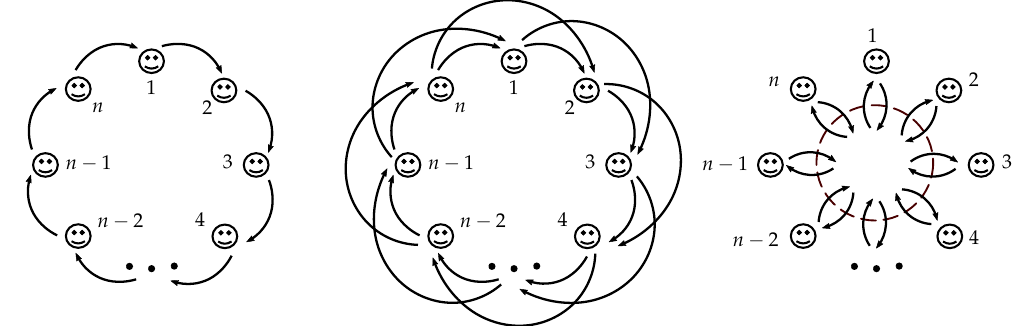
Figure 1. An interpolating family of mechanisms. Left: simple giving circle (1-GCM). Center: 2-GCM. Right: linear public goods mechanism (LPGM); the LPGM is identical to the n -GCM as each player’s contribution is then equally distributed over all her/his successors including